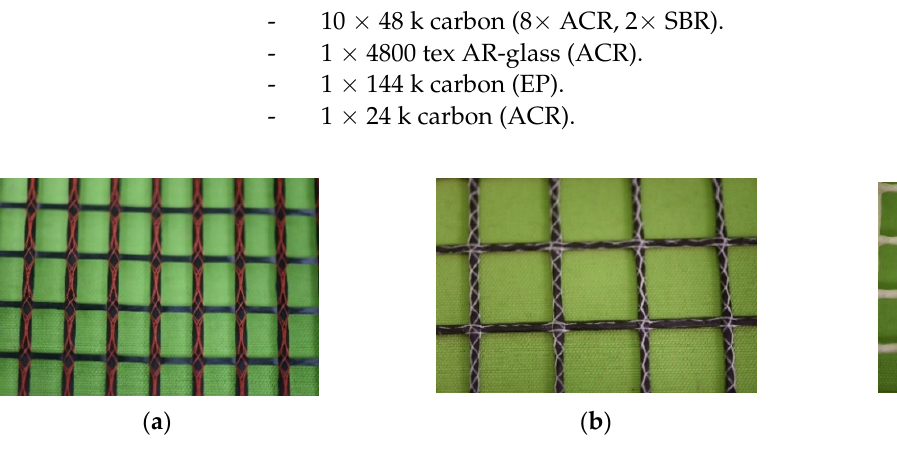
Figure 8. Photos of different textiles: ( a ) carbon textile, ( b ) carbon textile, ( c ) AR–glass textile.